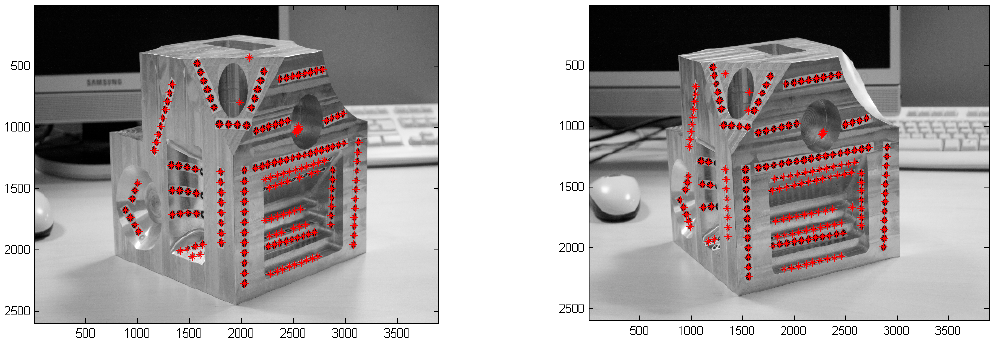
Figure 5. Detection of marks in several images.